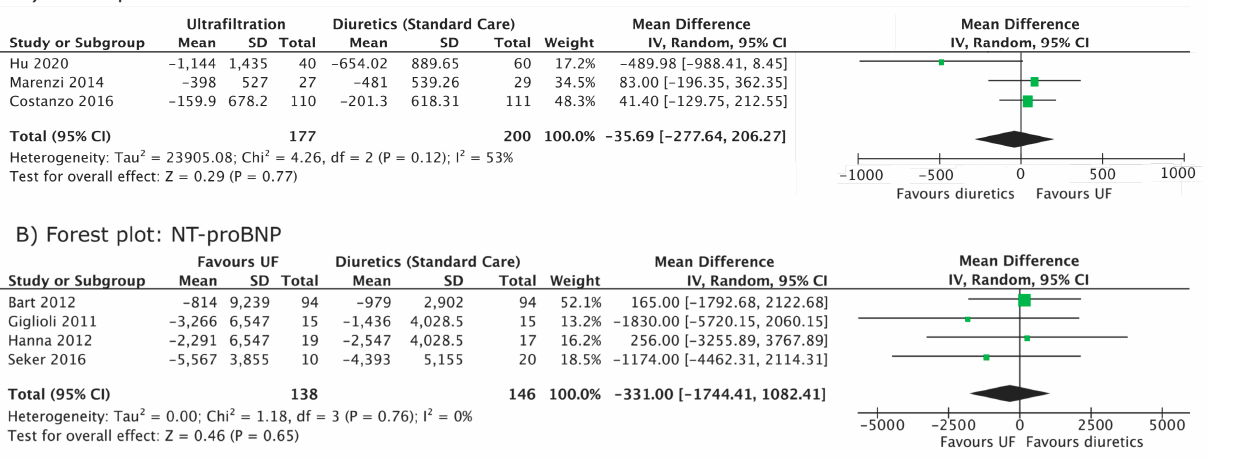
Table 3. Study outcomes.